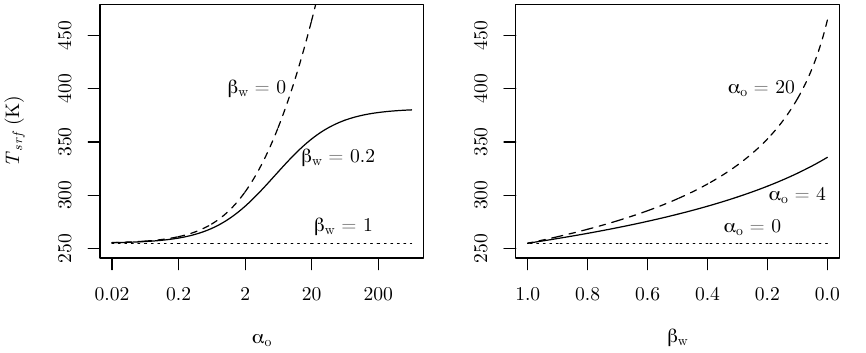
Figure 4. The dependence of the overall equilibrium surface temperature on the parameters α o and β w in the window-grey model (Eq. 30). β w = 0 corresponds to the grey case. T eff,eq =